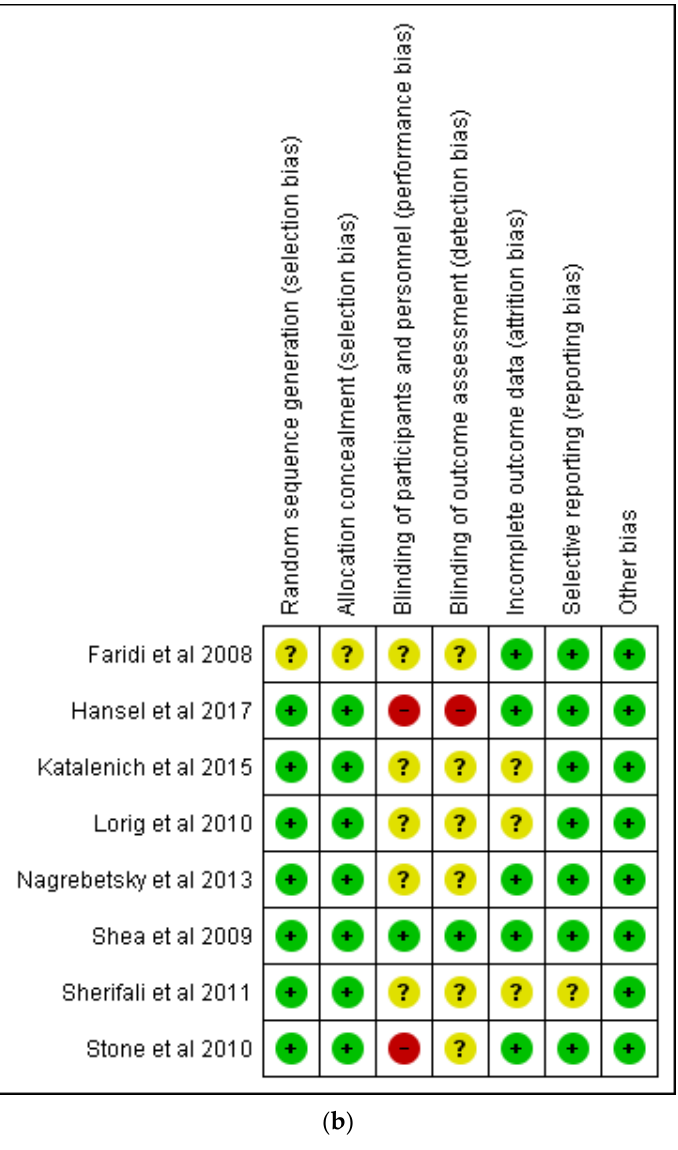
Figure 2. ( a , b ): showing risk of bias graph ( a ) and risk of bias summary ( b ) of included studies [29–